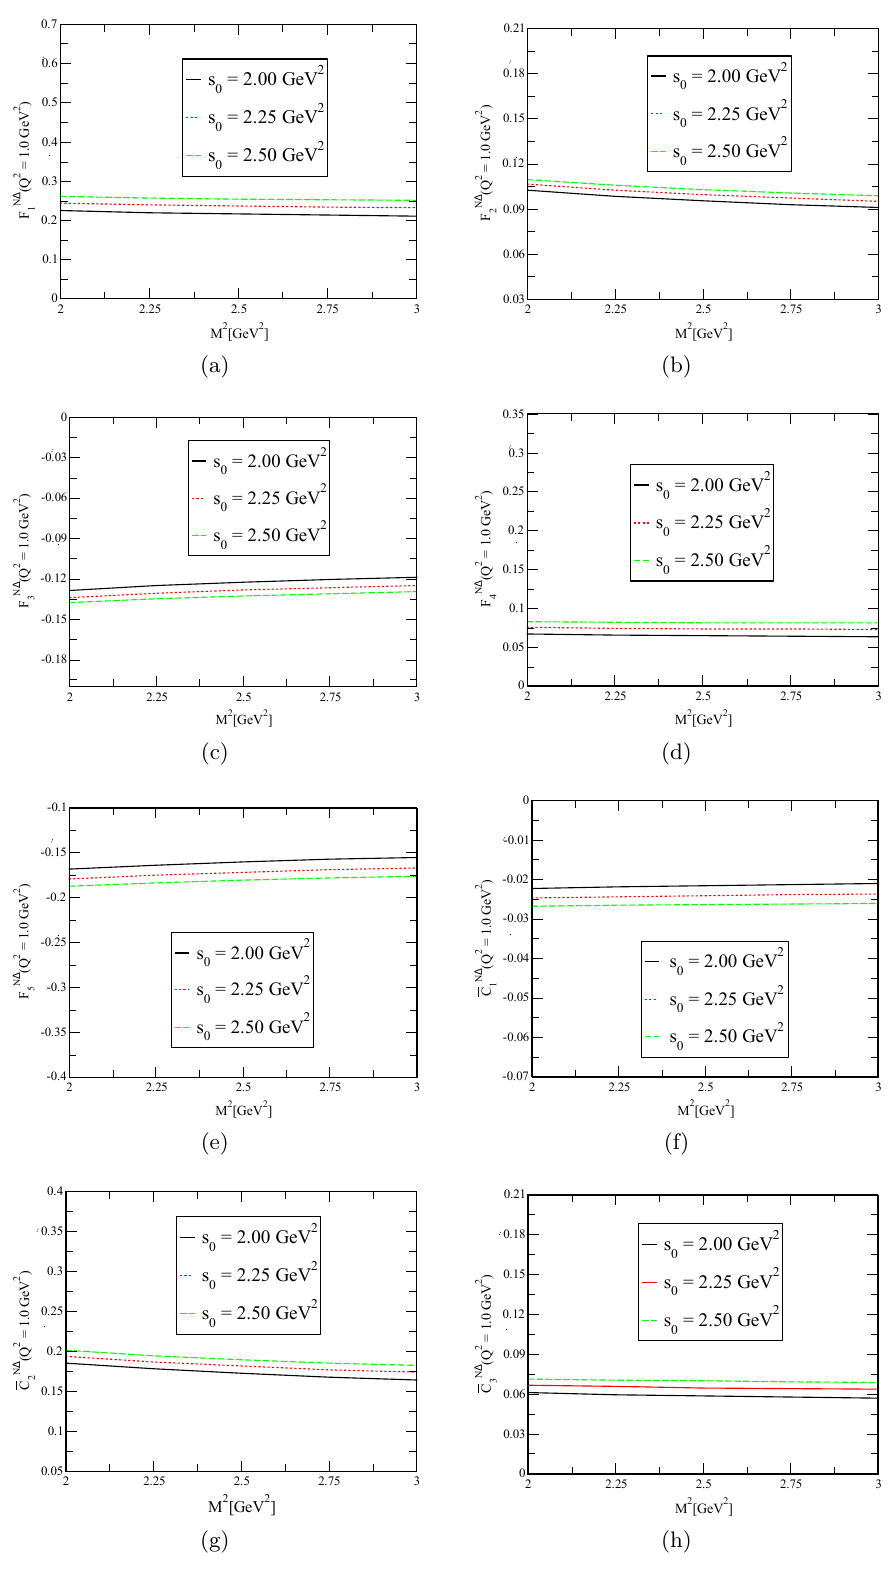
Figure 2 . The dependence of the N → ∆ transition GFFs on M 2 at Q 2 = 1 . 0 GeV 2 and three fixed values of the s 0 and set-II